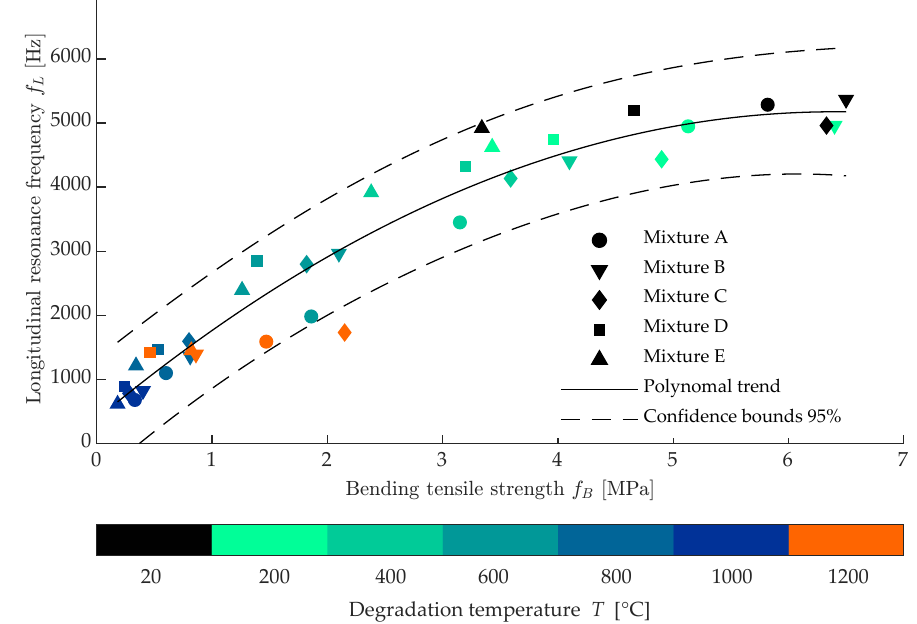
Figure 9. Correlation comparision of longitudinal frequency F L and bending tensile strength f B